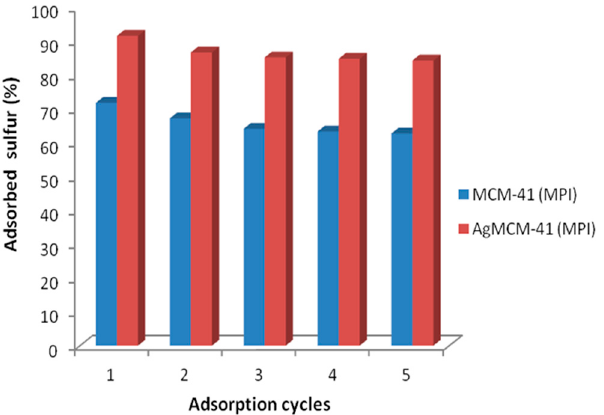
Figure 10. Sulfur adsorption results for the regenerated materials. Experimental conditions: room temperature and pressure.